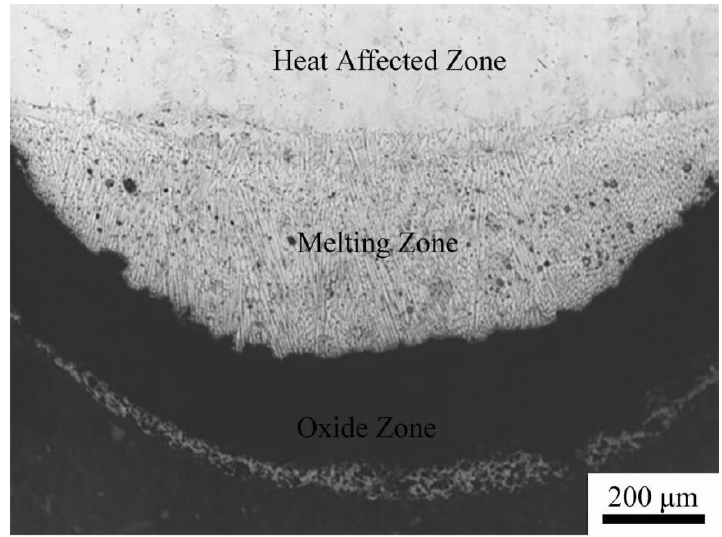
Figure 6. SEM photographs of combustion area of a stainless steels, reproduced from [52] with permission from ASTM, 2020.